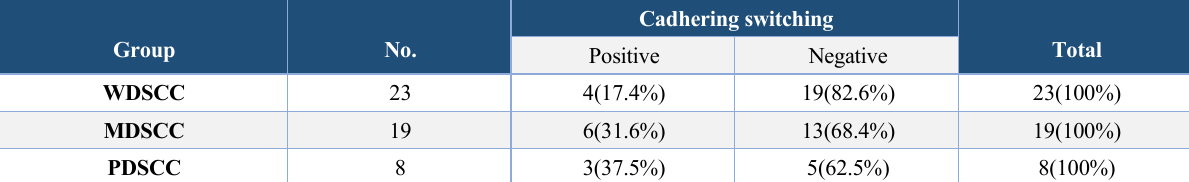
Table 4. Cadherin Switching in different histopathological grades of OSCC Cadhering switching Group No. Total Positive Negative WDSCC 23 4(17.4%) 19(82.6%) 23(100%) MDSCC 19 6(31.6%) 13(68.4%) 19(100%) PDSCC 8 3(37.5%) 5(62.5%)